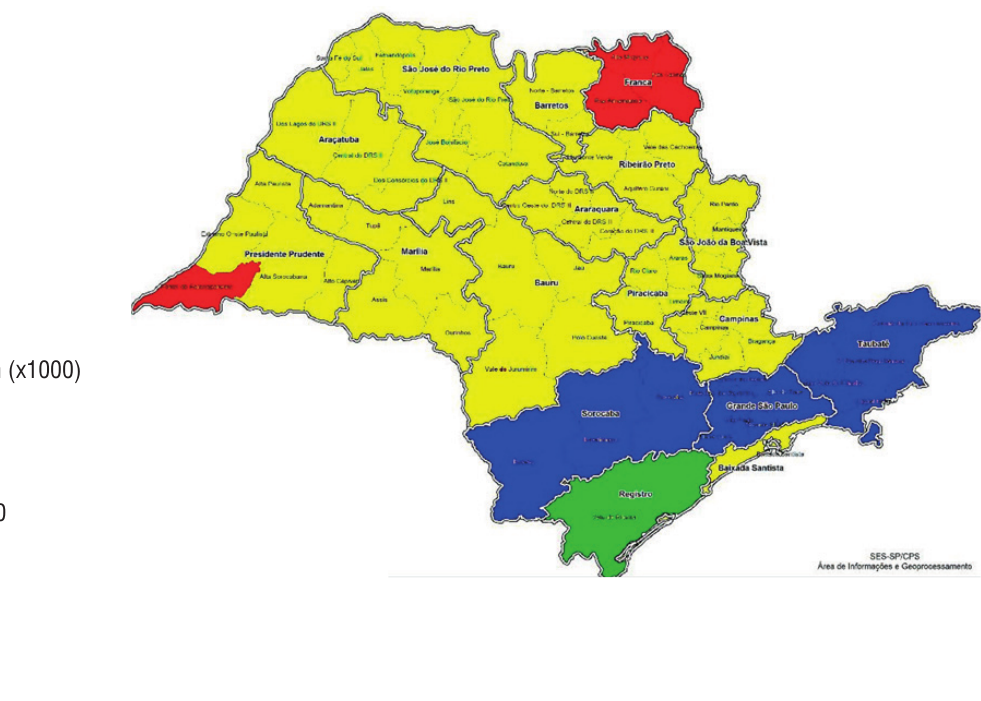
figure 6 - Map with the areas with high arsenic concentration